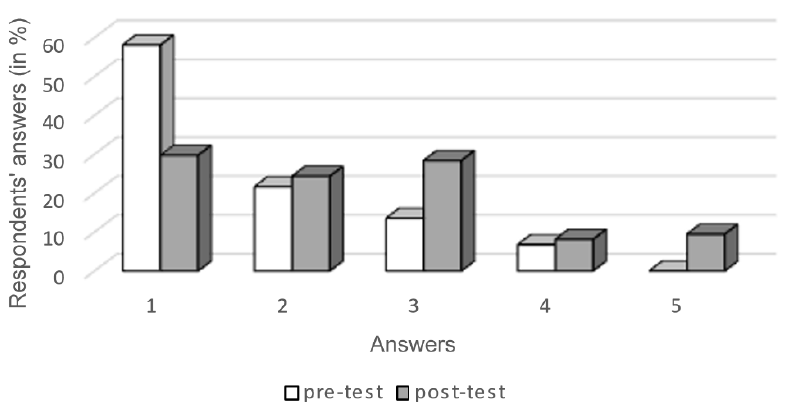
Figure 4. Respondents’ answers to question no. 3 (when learning algorithms, I consider it important to be able to adapt the algorithm to the problem) in pre-test and post-test (in%).